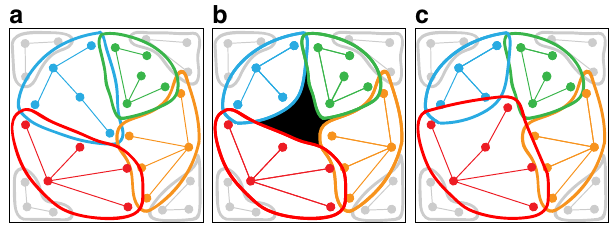
Fig. 2 Diagrammatic representation of adaptive evolution of immune supertypes. Supertypes (STs) evolve an epitope/paratope space within a population that results in a balanced polymorphism during Red Queen